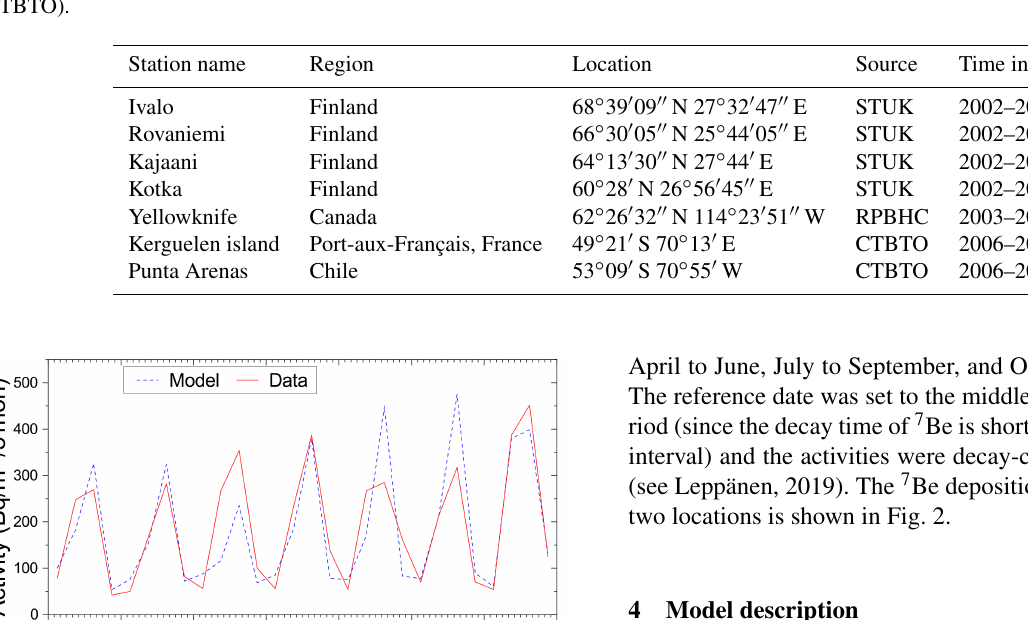
Table 1. List of stations whose data were used for the present study. Data sources are the Finnish National Radiation and Nuclear Safety Au- thority (STUK), the Radiation Protection Bureau of Health Canada (RPBHC), and the Comprehensive Nuclear Test-Ban-Treaty Organization (CTBTO).